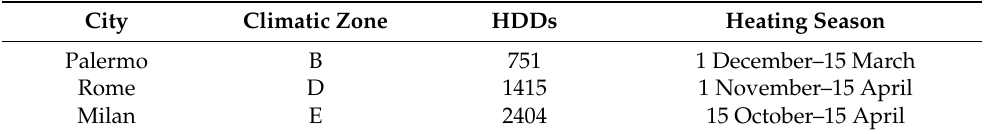
Table 1. Climatic and operational data in the selected